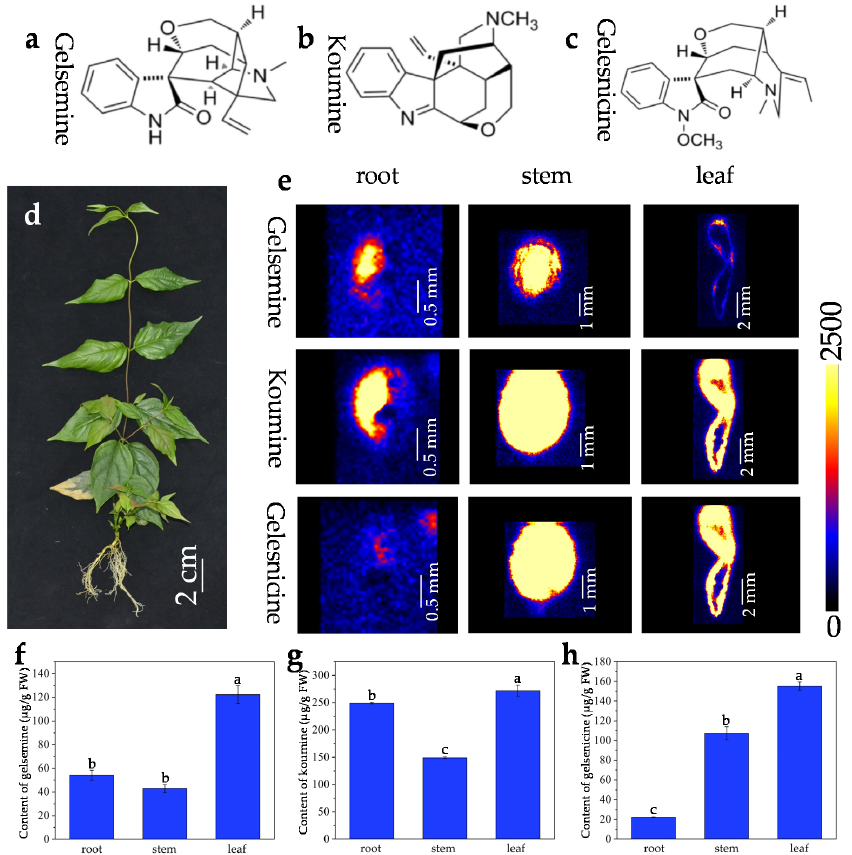
Figure 1. G. elegans plant and distribution of three alkaloids in mature organs/tissues. ( a ) Chemical structure of gelsemine ( a ), koumine ( b ), and gelsenicine ( c ); ( d ) mature G. elegans plant (about one year old); ( e ) in situ visualization of three alkaloids in mature G. elegans organs/tissues by DESI-MSI. The contents of gelsemine ( f ), koumine ( g ), and gelsenicine ( h ) in organs/tissues of mature G. elegans . The error bars indicate the standard deviations of three biological replicates, and statistical significance was evaluated using Microsoft Excel software. Different lowercase letter above the bars represented significance at the level of p < 0.05, and the same letter denotes a non-significant difference between the